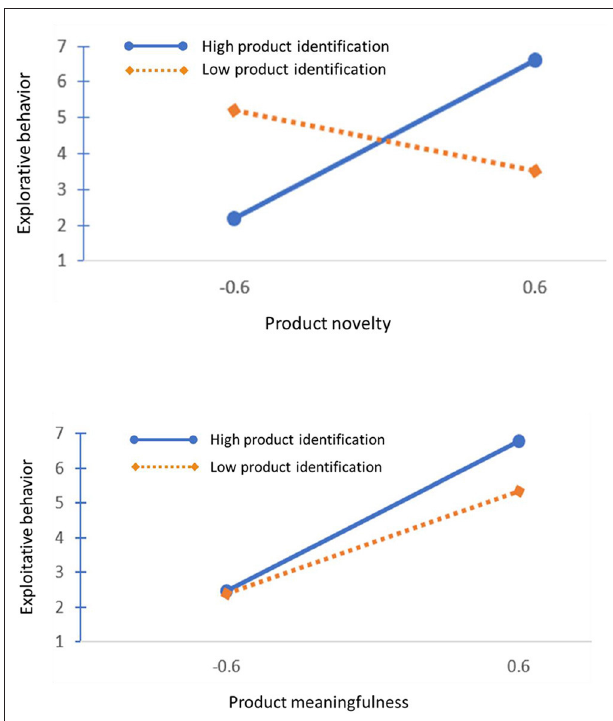
FIGURE 3 | Moderating effect of product identification on the regression models.